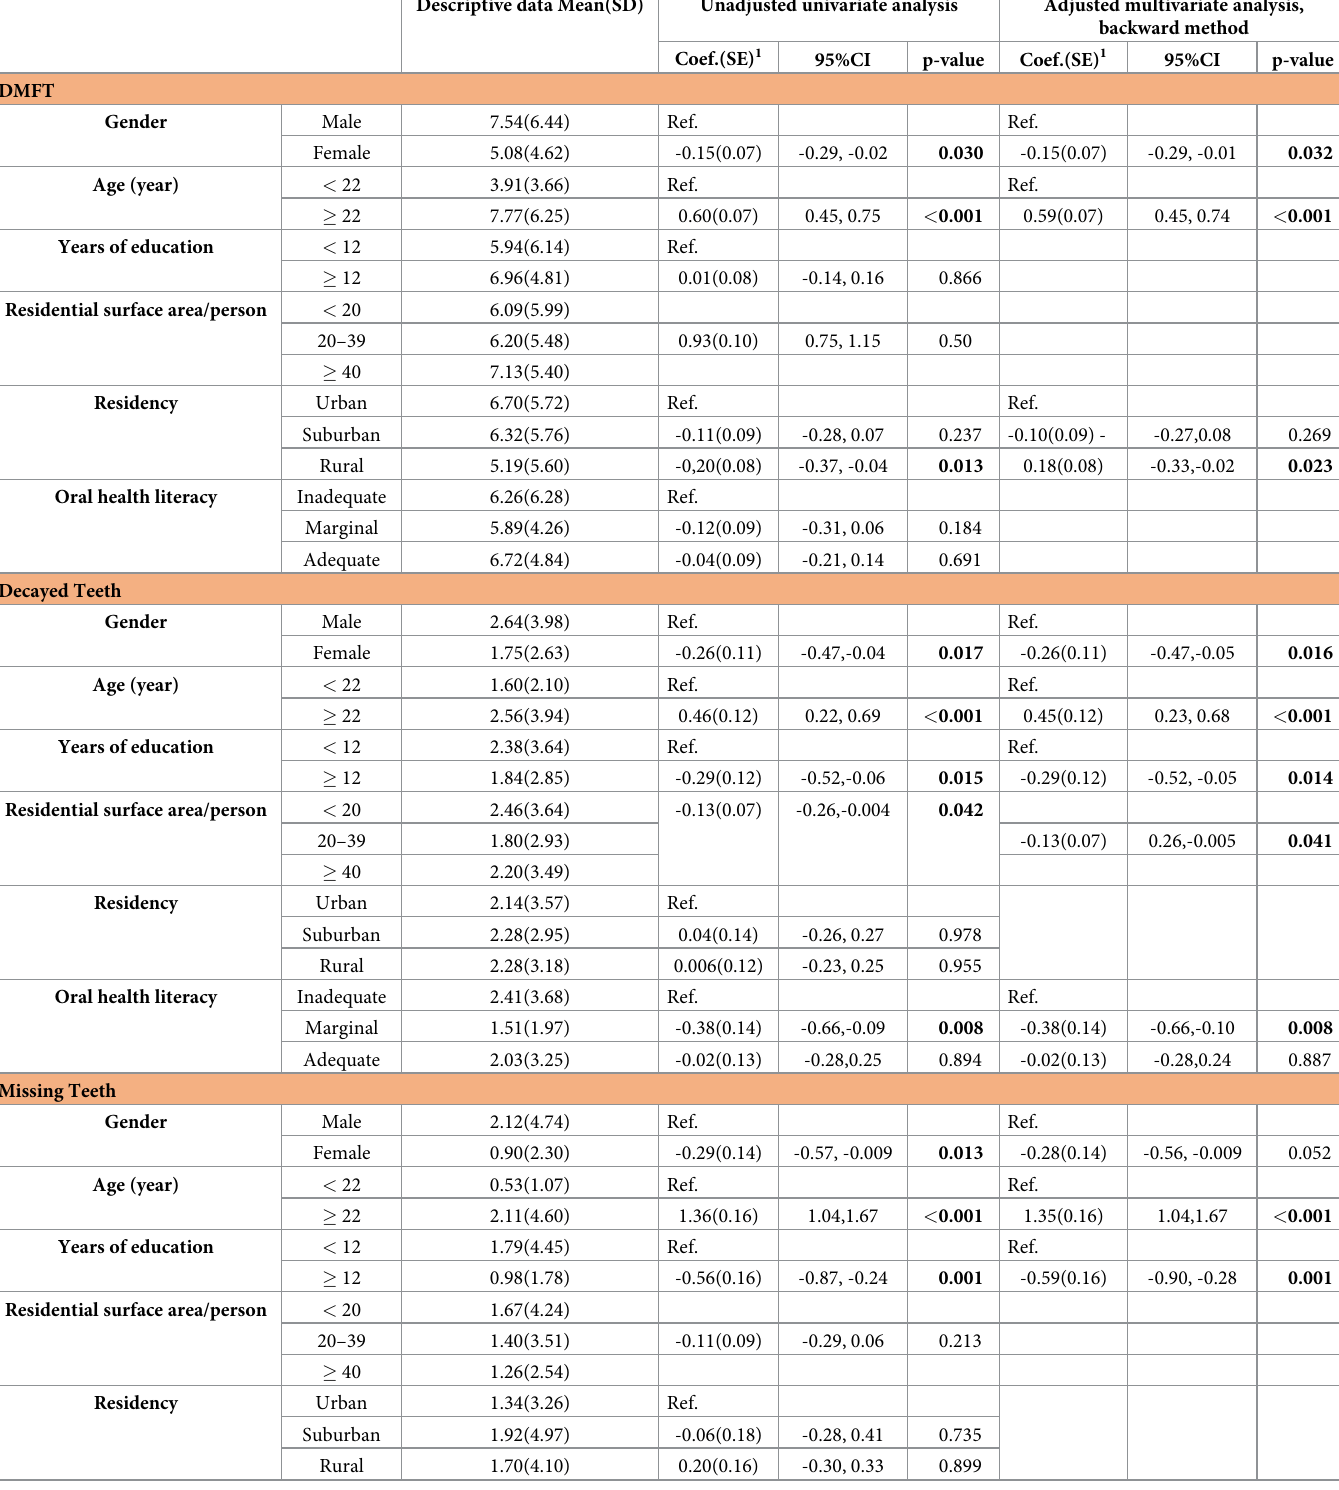
Table 2. Oral health literacy and demographic characteristics and their relationships with dental health status of the study participants in SCS (Save Couples’ Smile) study